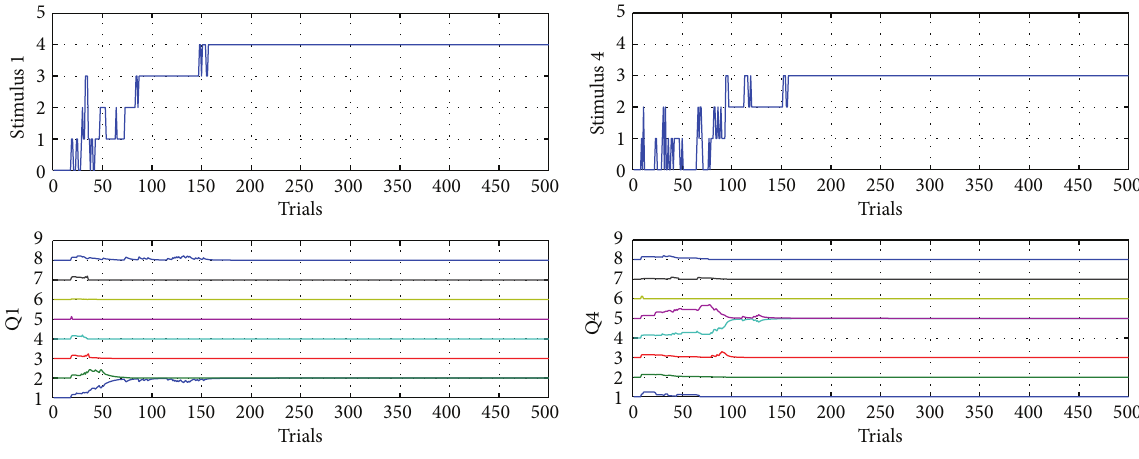
(a) The evolution of the number of the predators which find the target (b) The evolution of the number of the predators which find the target in the first sector and the corresponding weight in the fourth sector and the corresponding weight Figure 5: The learning process of partial state-action